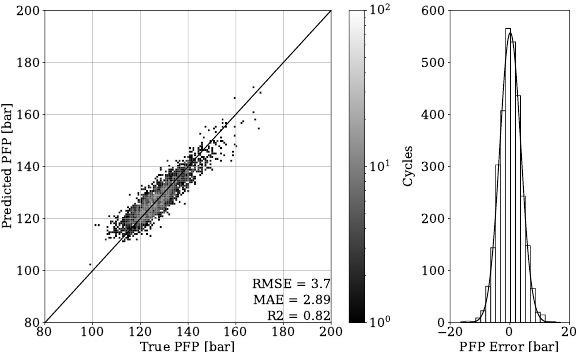
Figure 16. PFP regression of test set from engine 2.